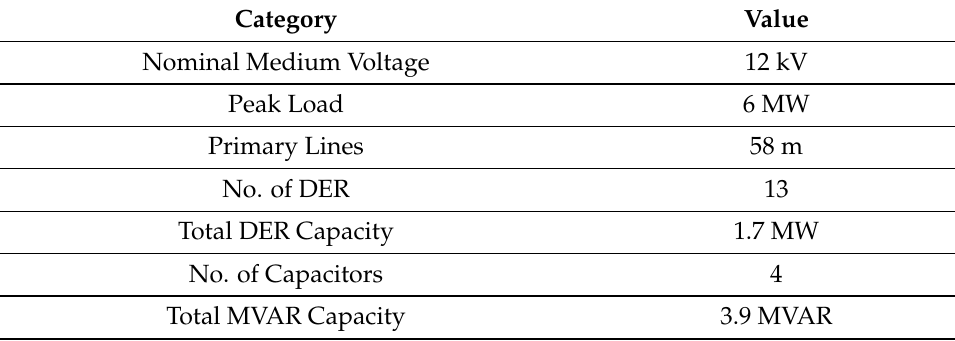
Figure 3. Topology of the test system with regulators (red) and PV buses (yellow) [21]. Table 1. Test system